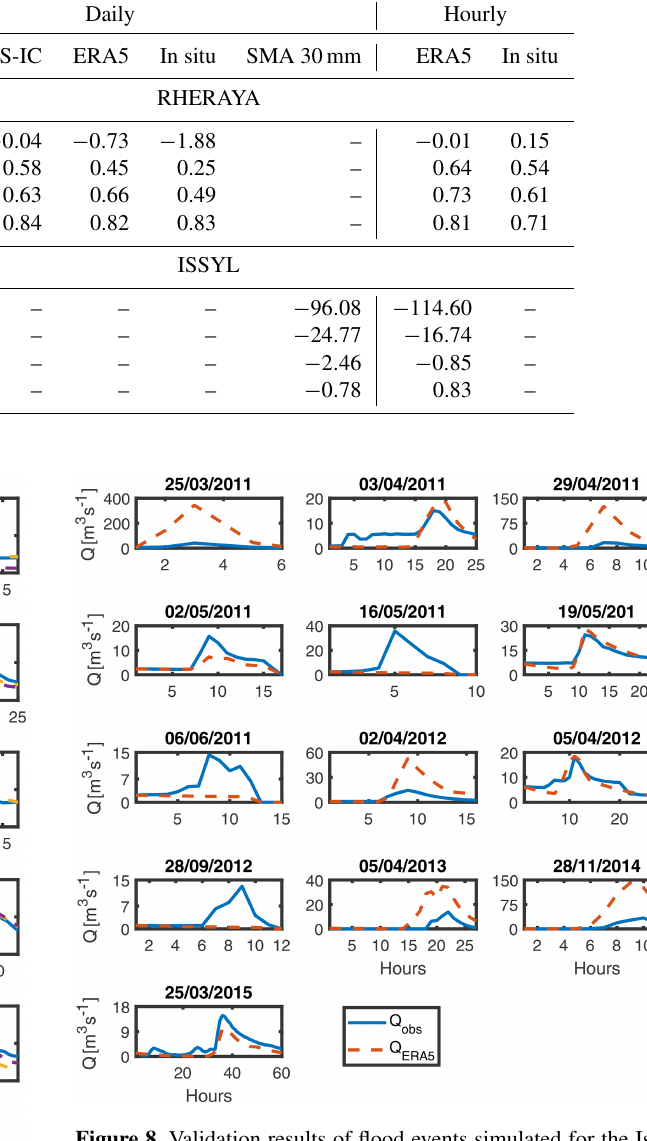
Figure 8. Validation results of flood events simulated for the Issyl basin using ERA5 soil moisture at the hourly time step: the observed hydrographs ( Q obs ) are compared to the simulated hydrographs us- ing ERA5 ( Q ERA5 ) to estimate the antecedent soil moisture condi- tions. The selected flood events are described in Table